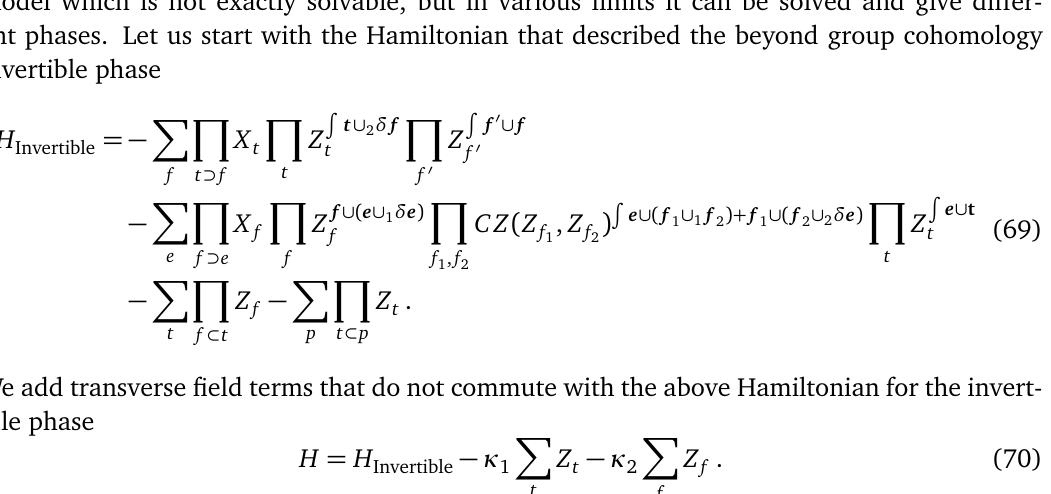
Figure 7: The interface on the membrane operator versed on one side of the interface. We use the ordering convention in the product of operators such that the operators that are diagonal in the Z eigenbasis (the Z and CZ operators in the figure) appear on the right of the X operators, and the product (cid:81) (cid:81) (cid:81) X Z CZ takes the form